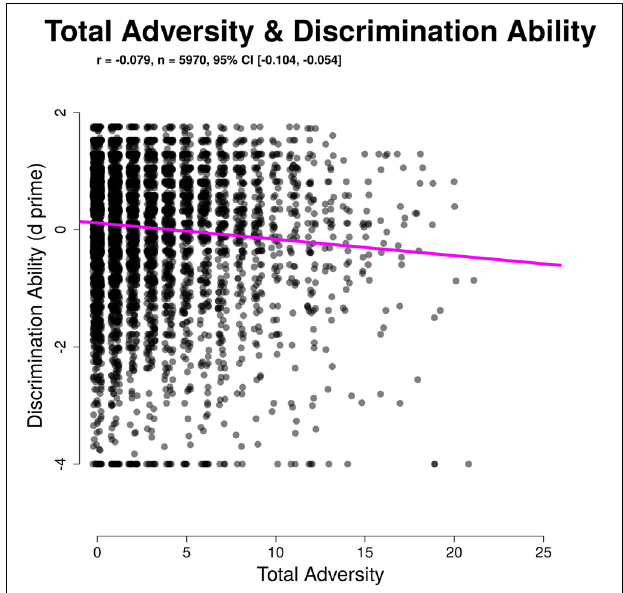
FIGURE 3 | Significant association between total adversity and discrimination